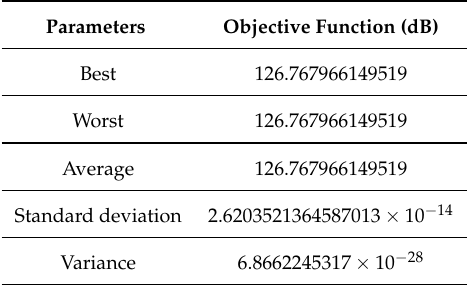
Table 4. Table of the results from the statistical analysis.